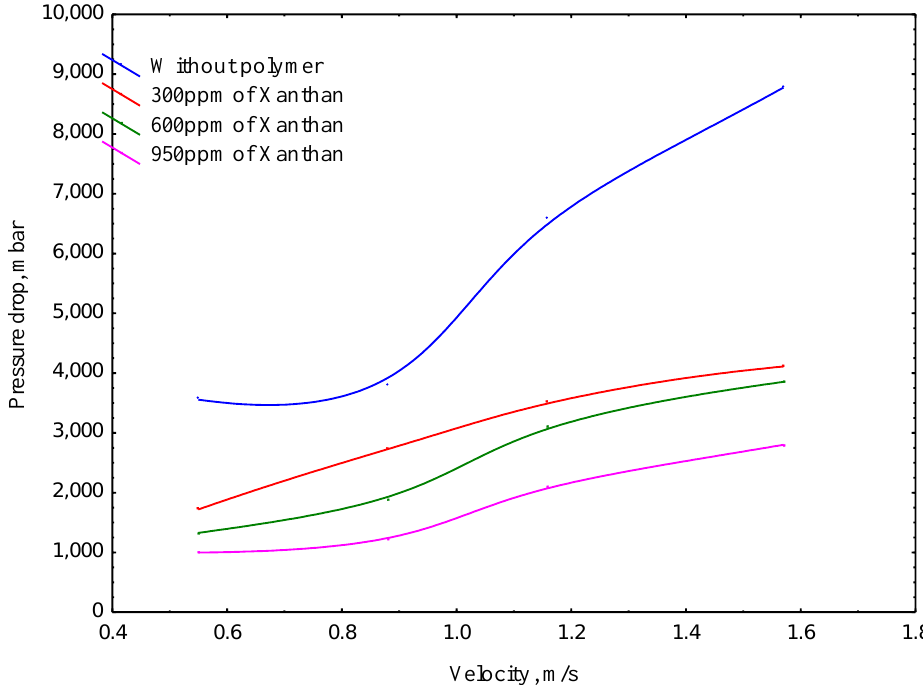
Figure 5. The pressure drop with different xanthan concentrations and water velocities.